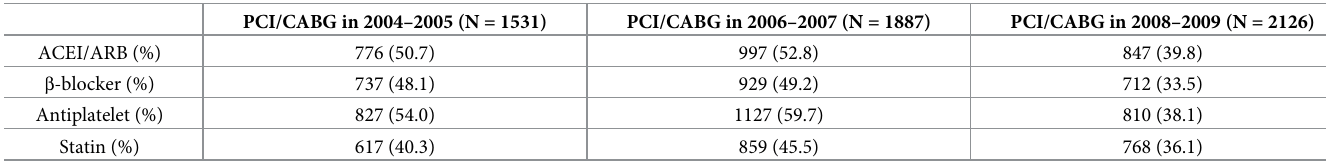
Table 9. Trend in prescription changes during the follow-up